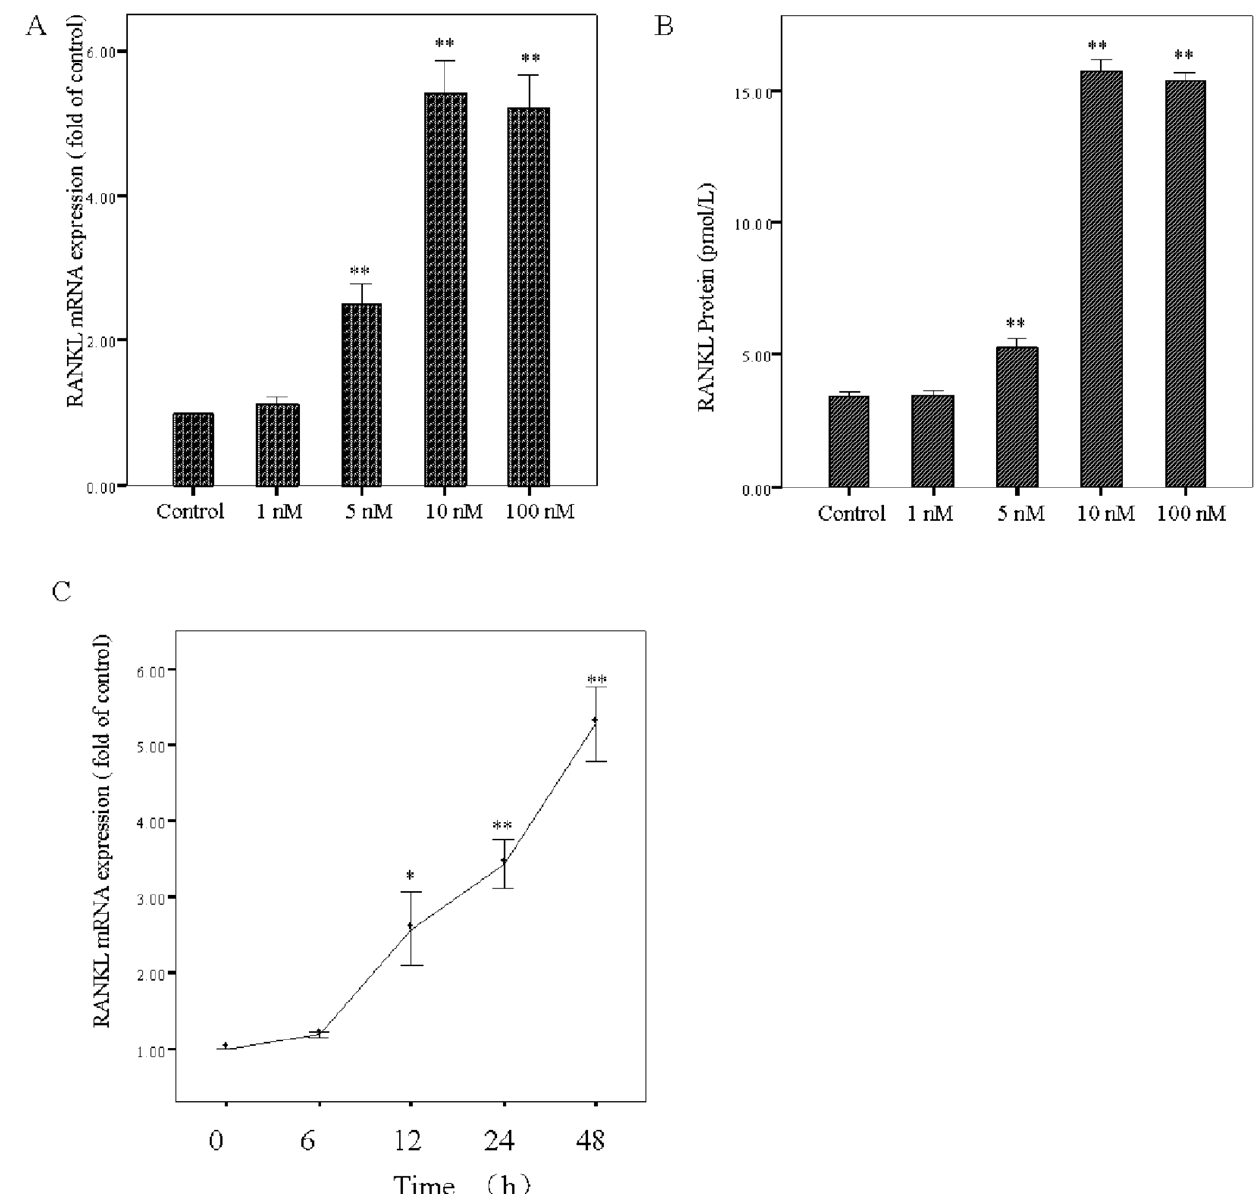
Figure 1. Effect of invitro incubation of calcifying vascular smooth muscle cells (CVSMCs) with insulin on RANKL expression. Cells were exposed to vehicle or 1–100 nM insulin for 48 h or to 10 nM insulin for 6–48 h. (A) The dose–response of insulin on RANKL mRNA levels measured by real-time polymerase chain reaction (PCR) in cultured CVSMCs. Data are shown as percentage over basal values. (B) The dose–response of insulin on RANKL protein secreted by CVSMCs in the culture medium. (C) Time course of effects of 10 nM insulin on RANKL mRNA levels in cultured CVSMCs. (D) Time course of effects of 10 nM insulin on RANKL protein secretion in the culture medium by CVSMCs. The dots represent the percent of control RANKL levels at various time points. ( n =3, * p , 0.05 vs. control, ** p , 0.01 vs.